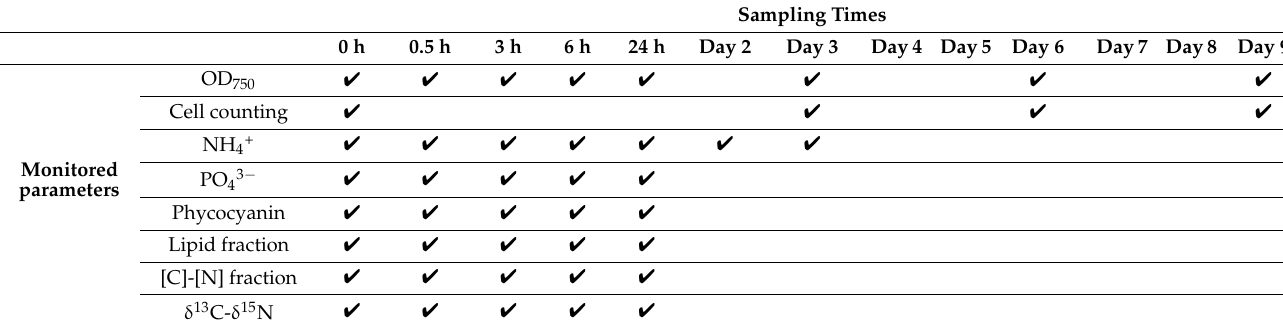
Table 1. Time sheet of the sampling performed on each of the biological replicates and the analyses that were carried out on each of these